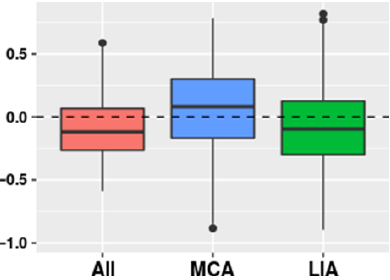
Figure 7. Precipitation–temperature correlations. Correlations be- tween the temperature and precipitation ensemble members based on 1000 randomly chosen pairs for the period 100–1500 yrBP (“All”) and the MCA and LIA individually. See Fig. 4 for expla- nation of the box plots and significance.